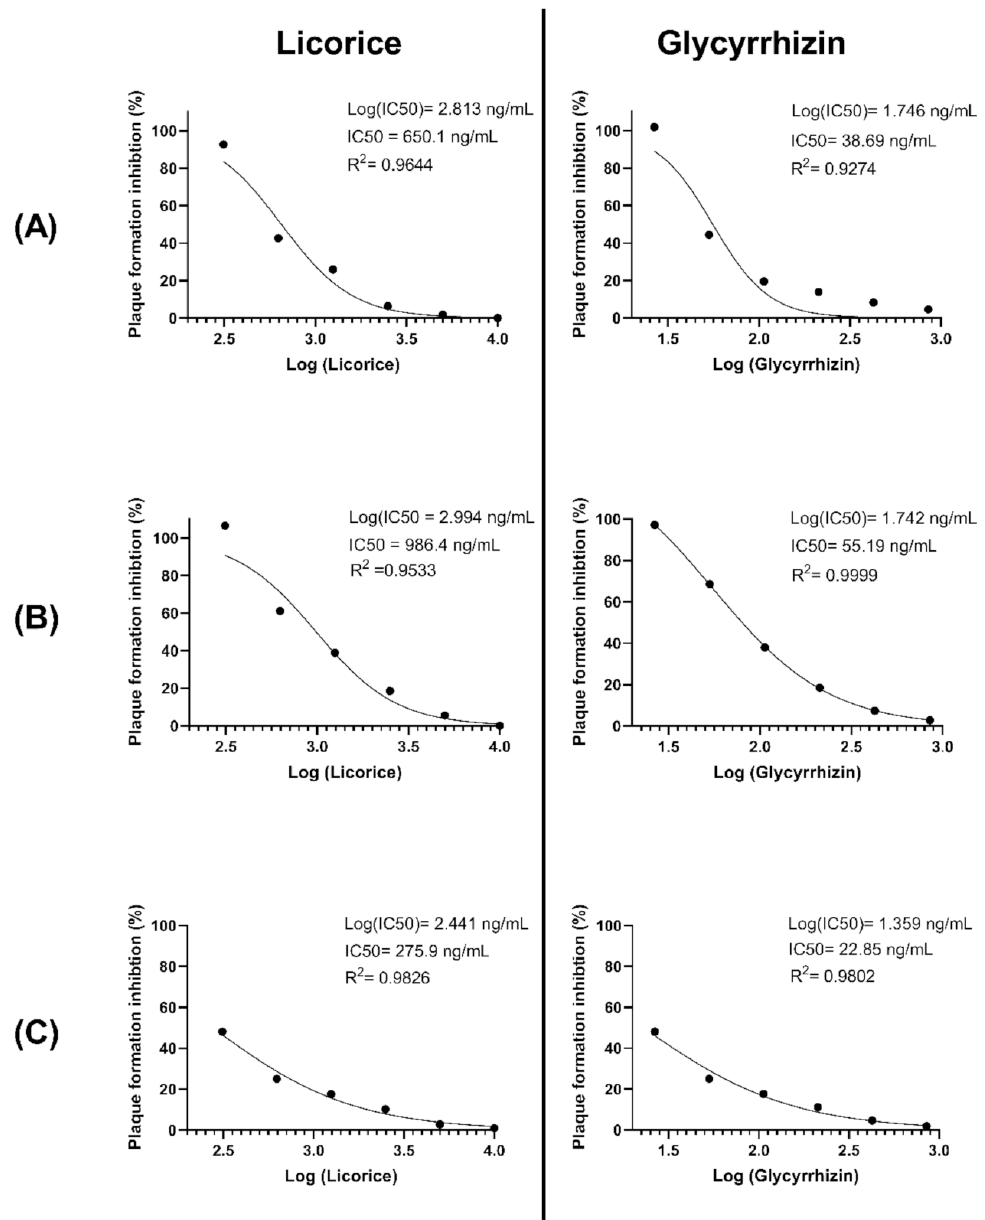
Figure 9. Calculation of the half maximal inhibitory concentration (IC50) of licorice and glycyrrhizin on SARS-CoV-2 plaque forming efficiency. The IC50, log (IC50), and R squared (R2) for each compound under each treatment protocol are shown. Details about treatment protocols ( A – C ) are found in Section 3.5.4. (the effect of licorice and glycyrrhizin on viral induced cytopathic effect (CPE) and viral plaque forming efficiency